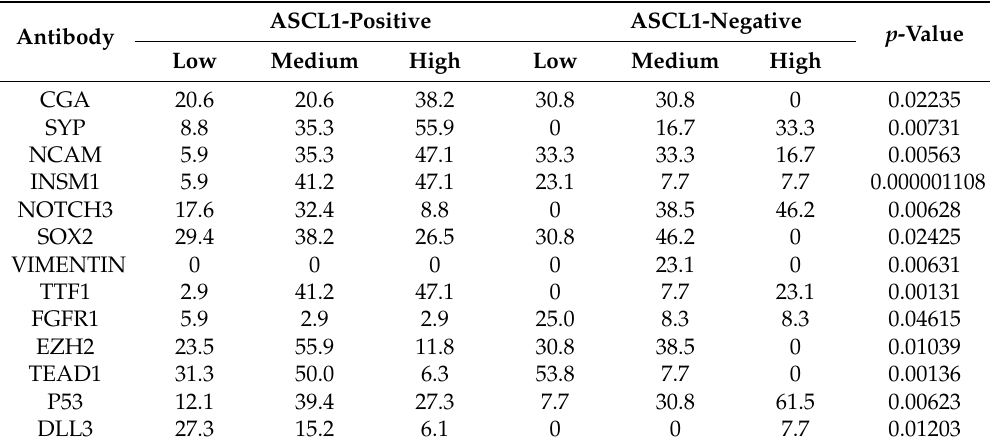
Table6. SignificantdifferencesweredetectedintheexpressionofE-CADHERIN,E2F1,RB1,andP53between the NEUROD1-positive and NEUROD1-negative groups ( p < 0.05). The expression of E-cadherin, E2F1, RB1, and P53 was slightly stronger in the NEUROD1-positive group than in the NEUROD1-negative